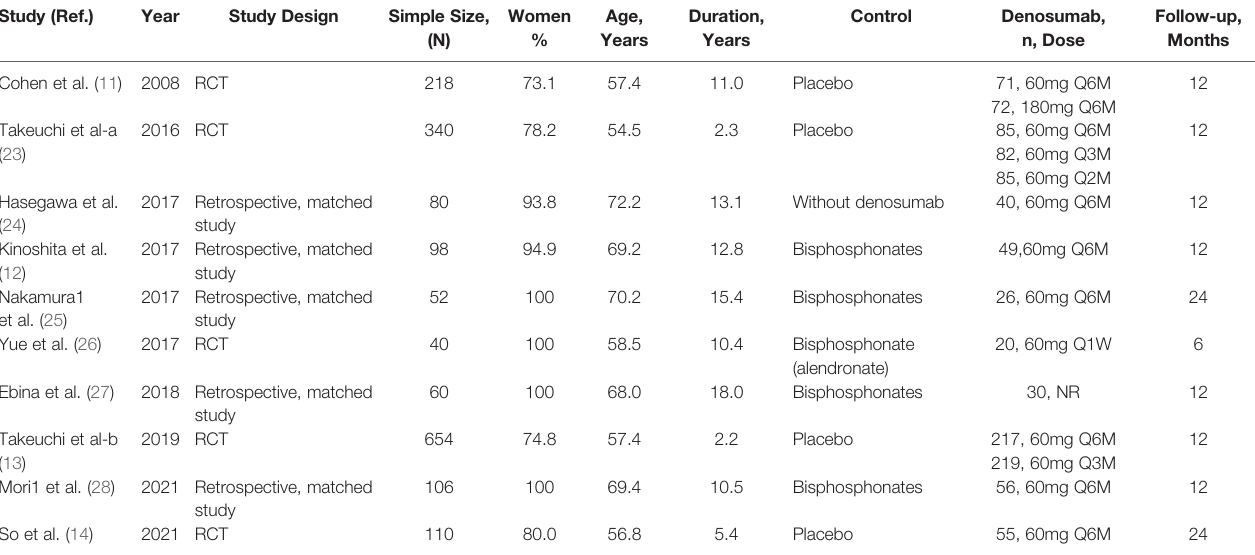
TABLE 1 | Baseline characteristics of the included studies. Study